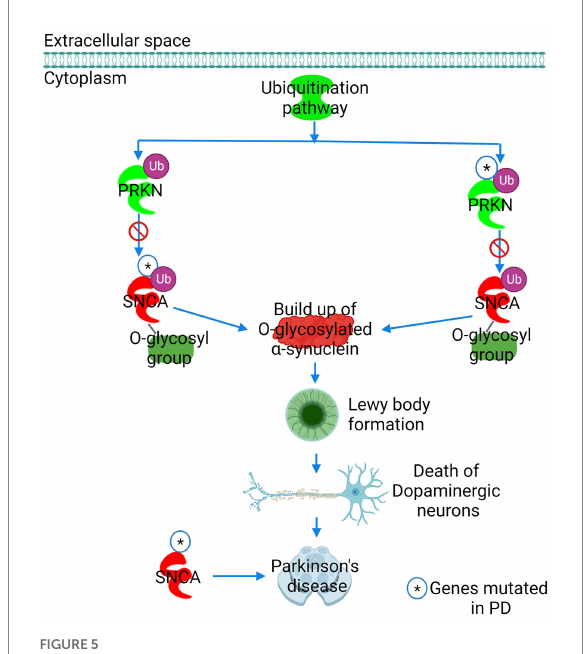
FIGURE 5 The role of α -synuclein in Parkinson’s disease (PD) predicted by IPA. PD was ranked as the leading pathway of α -synuclein toxicity. The E3 ubiquitin ligase Parkin (PRKN) labels the glycosylated form of synuclein (SNCA) for proteasomal degradation. Mutation in either PRKN or SNCA precludes PRKN from binding to SNCA, preventing the proteasomal degradation of glycosylated α -synuclein. A build-up of glycosylated α - synuclein in neuronal cells results in the formation of Lewy bodies, leading to dopaminergic neuron death and PD. Figure created with